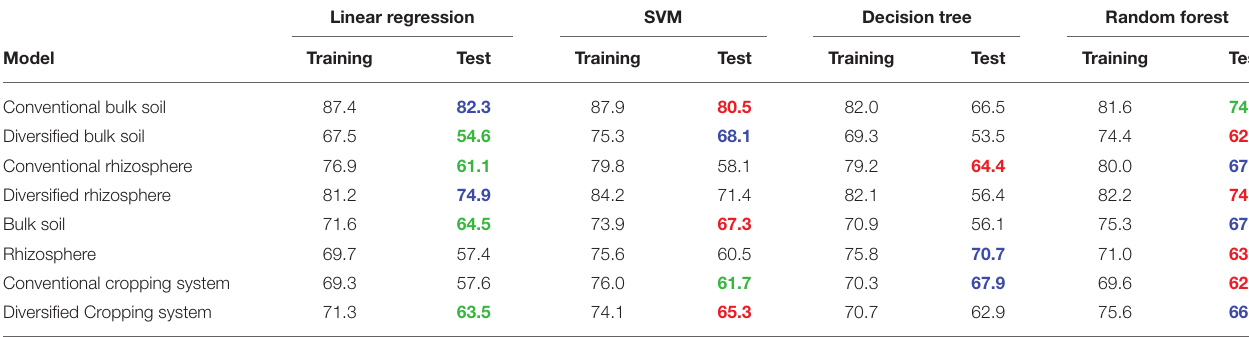
TABLE 1 | Machine learning model accuracy (% 1-MAPE). Linear regression SVM Decision tree